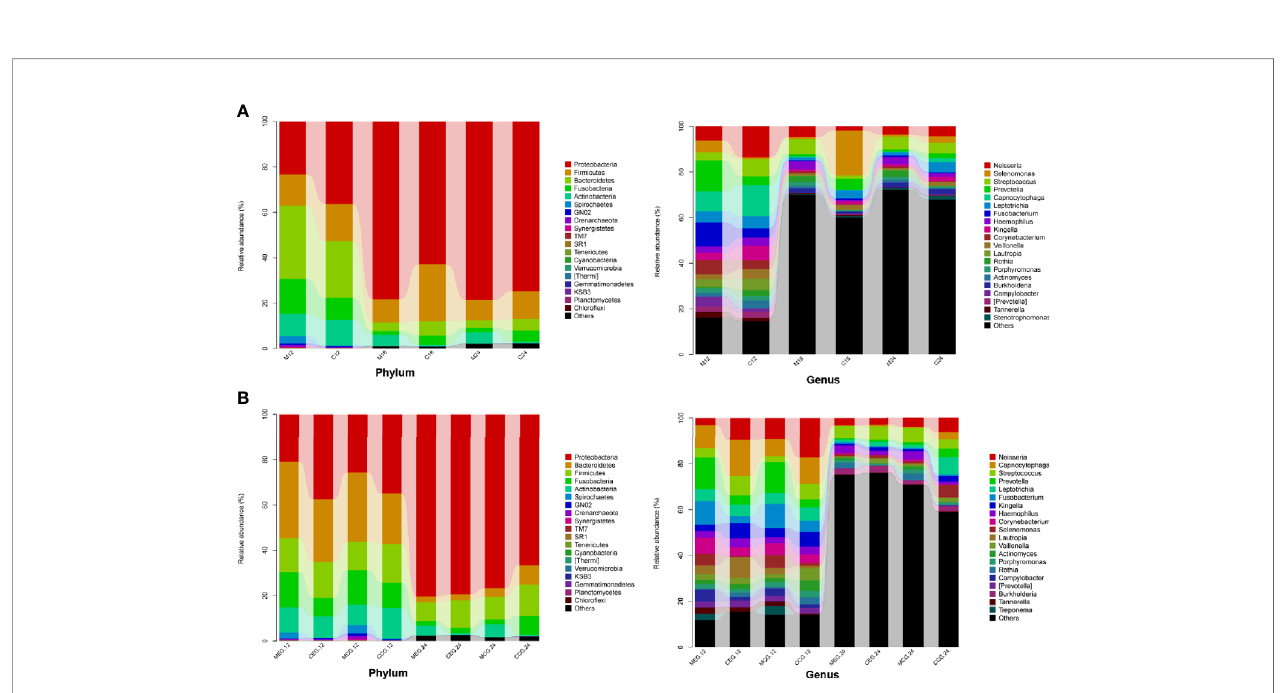
FIGURE 4 | Classi fi cation and compositional ratios of the different groups sequenced at the taxonomic level. (A) mother (M) and child (C) at 12, 18, and 24 months of age; (B) M or C in the exposure group (MEG or CEG) and the control group (MCG or CCG) at 12 and 24 months of